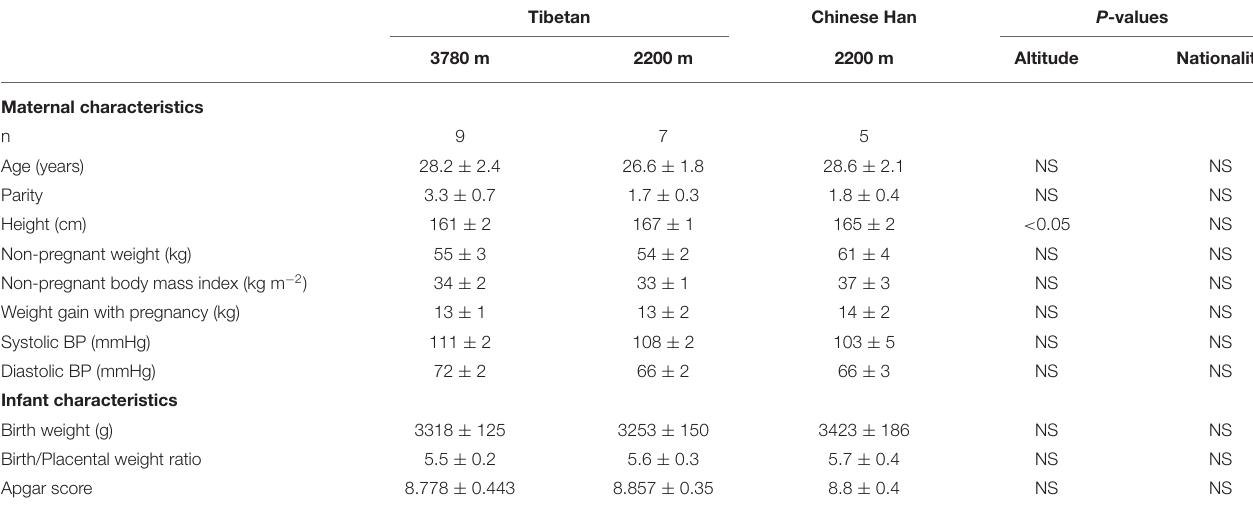
TABLE 1 | Maternal and infant characteristics.